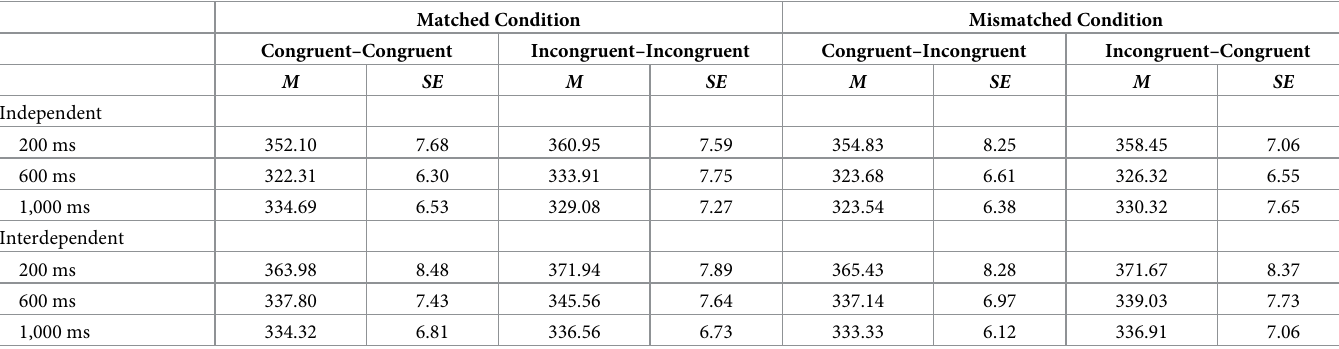
Table 3. Raw reaction times for European Canadians.